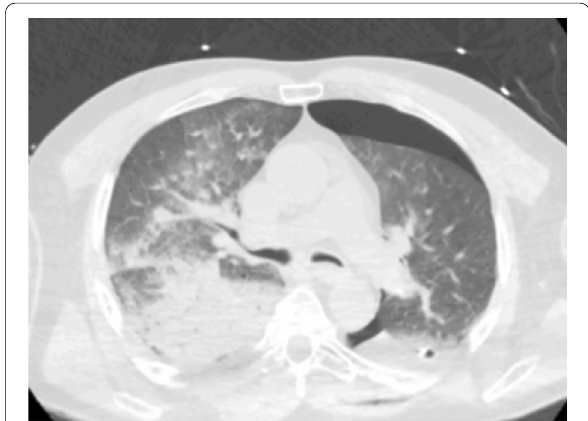
Fig. 11 Non‑cardiogenic pulmonary oedema. Axial CT image (parenchymal window) showing an ARDS after left lower lobe segmentectomy. In this case, ARDS abnormalities were predominant on the right side; gravito‑dependent pulmonary condensations are present with normal anterior lung, then ground‑glass opacities, then posterior alveolar condensations